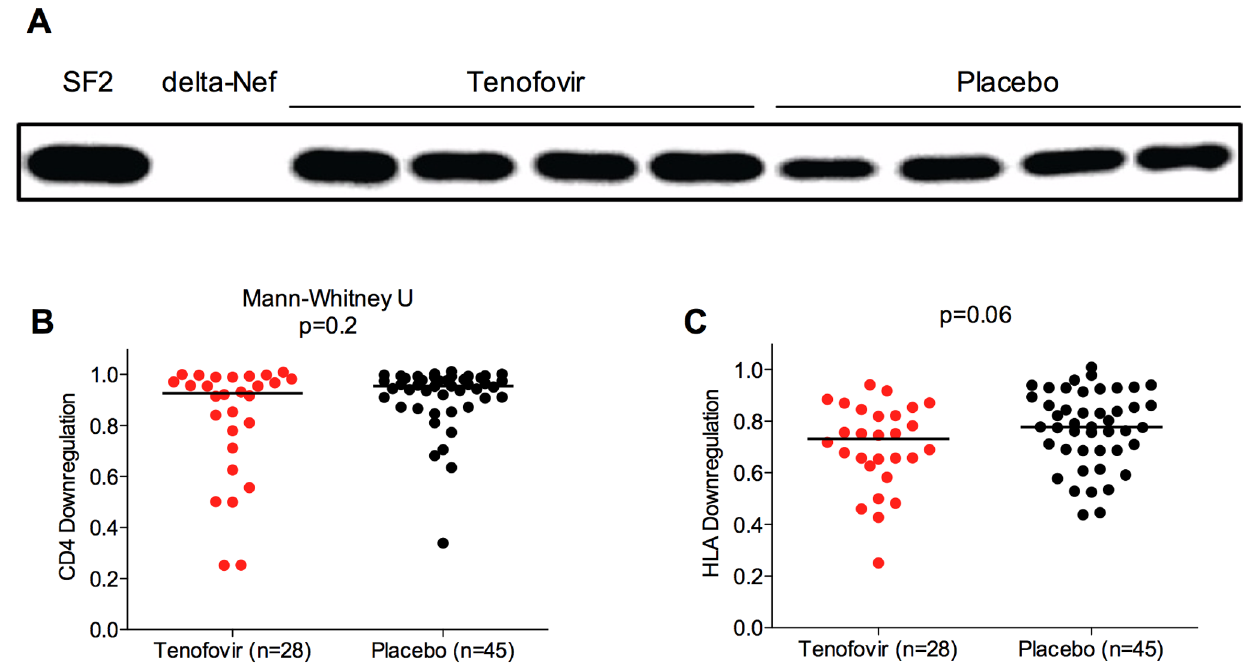
Figure 3. Functional analyses of Nef clones from treatment and placebo arms. Panel A: Selected Western blot results depict control SF2 Nef, empty (delta-Nef) plasmid and four samples each obtained from participants in the 1% tenofovir gel and placebo study arms. Panel B: Results for the CD4 downregulation activity of participant-derived nef isolates are shown, normalized to control SF2 Nef (which is equal to 1.0). Panel C: Results for the HLA-A*02 downregulation activity of participant-derived nef isolates are shown, normalized to control SF2 Nef (equal to 1.0). No significant differences in Nef-mediated CD4 or HLA downregulation function were observed between study arms (Mann-Whitney, p=0.2 and p=0.06, respectively).